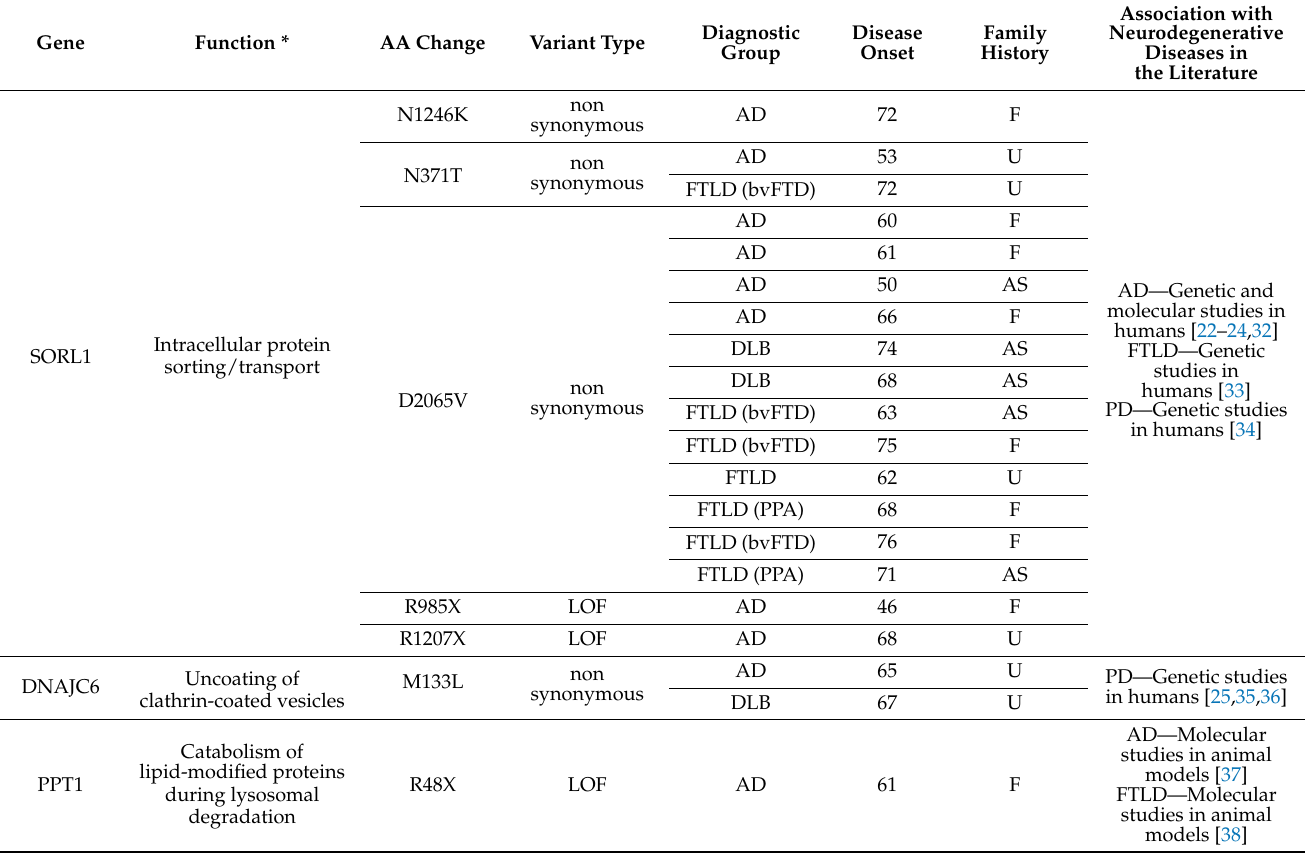
Table 4. List and clinical characteristics of previously reported disease-associated variants and predicted null variants.